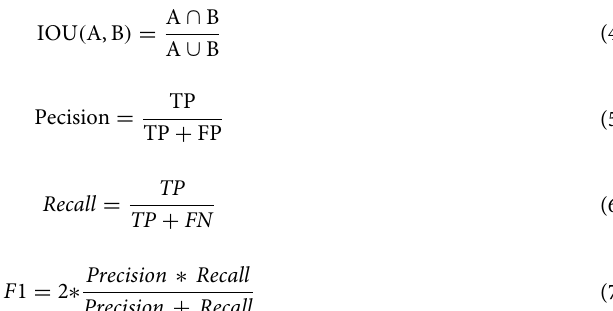
are proposed and successfully detecting different classes of objects in an image. As the state-of-the-art object detector, YOLOv4 obtained better performance in detection speed (FPS) and detection accuracy (mAP) than all available methods due to the characteristic of CSPDarknet-53 combined with Spatial Pyramid Pooling in Deep Convolutional networks (SPPnet). After expanding into a panoramic image, the YOLOv4 model is utilized to locate the area of the cutting tip. For performing the object detection task, approximately 500 panoramic images were utilized for the training dataset and the testing dataset consisted of 50 images. During the network training, the parameters are set as follows: the batch size is 5 epochs, the number of steps per epoch is 200, the learning rate is 0.0001, and the loss function is selected binary cross entropy. The results of the testing images are shown in Fig. 6.